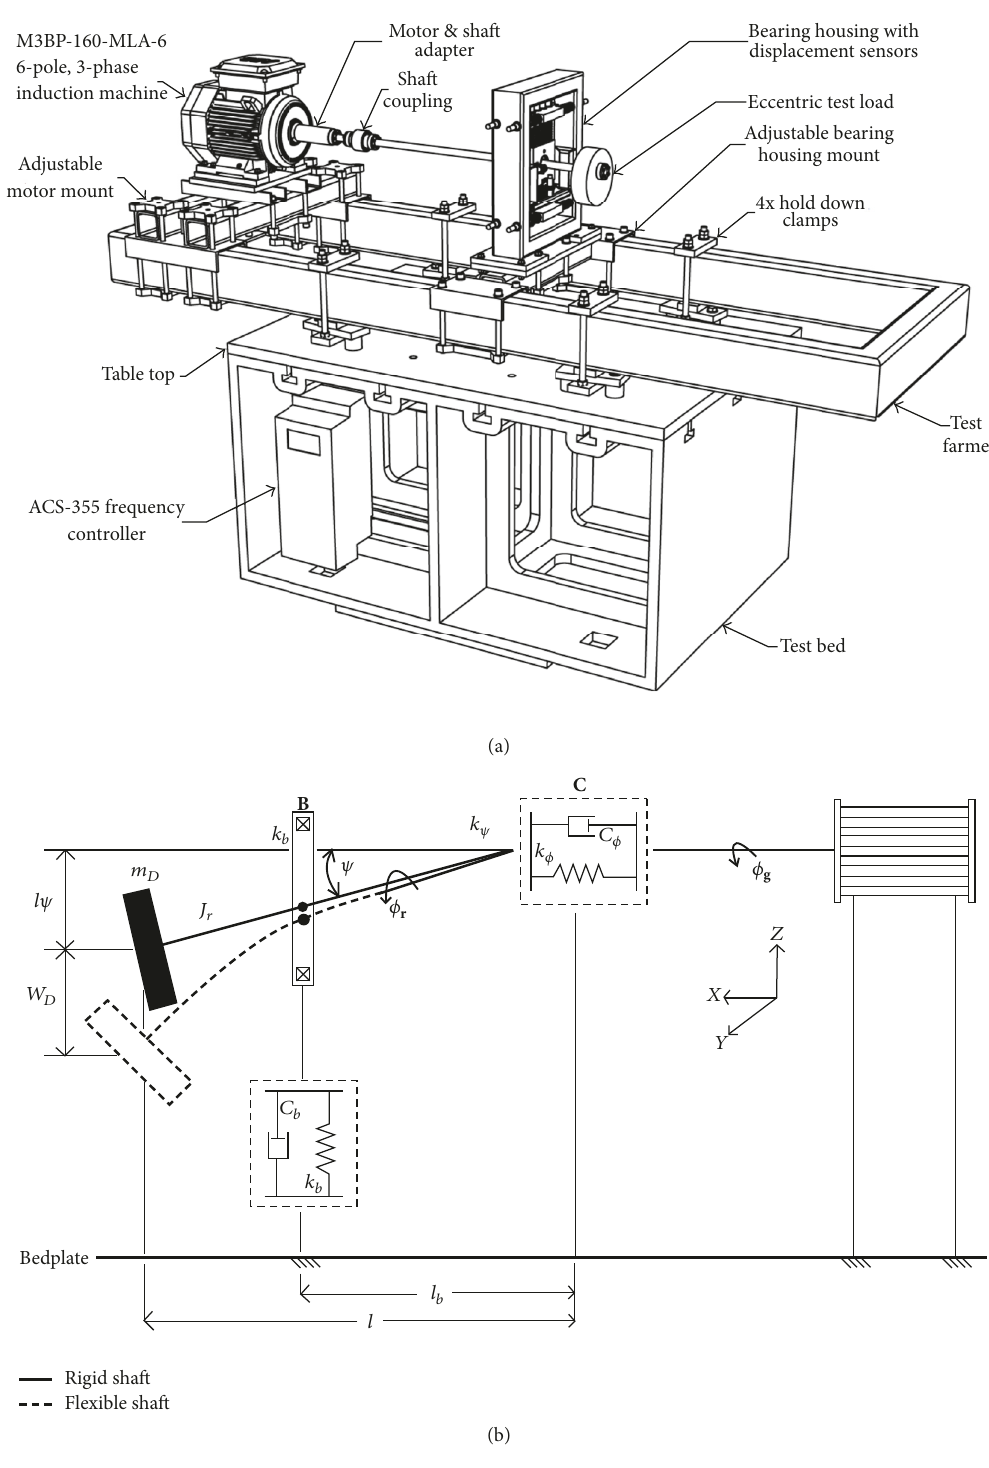
Figure 3: A sketch of the test rig (a) and an engineering abstract (b).